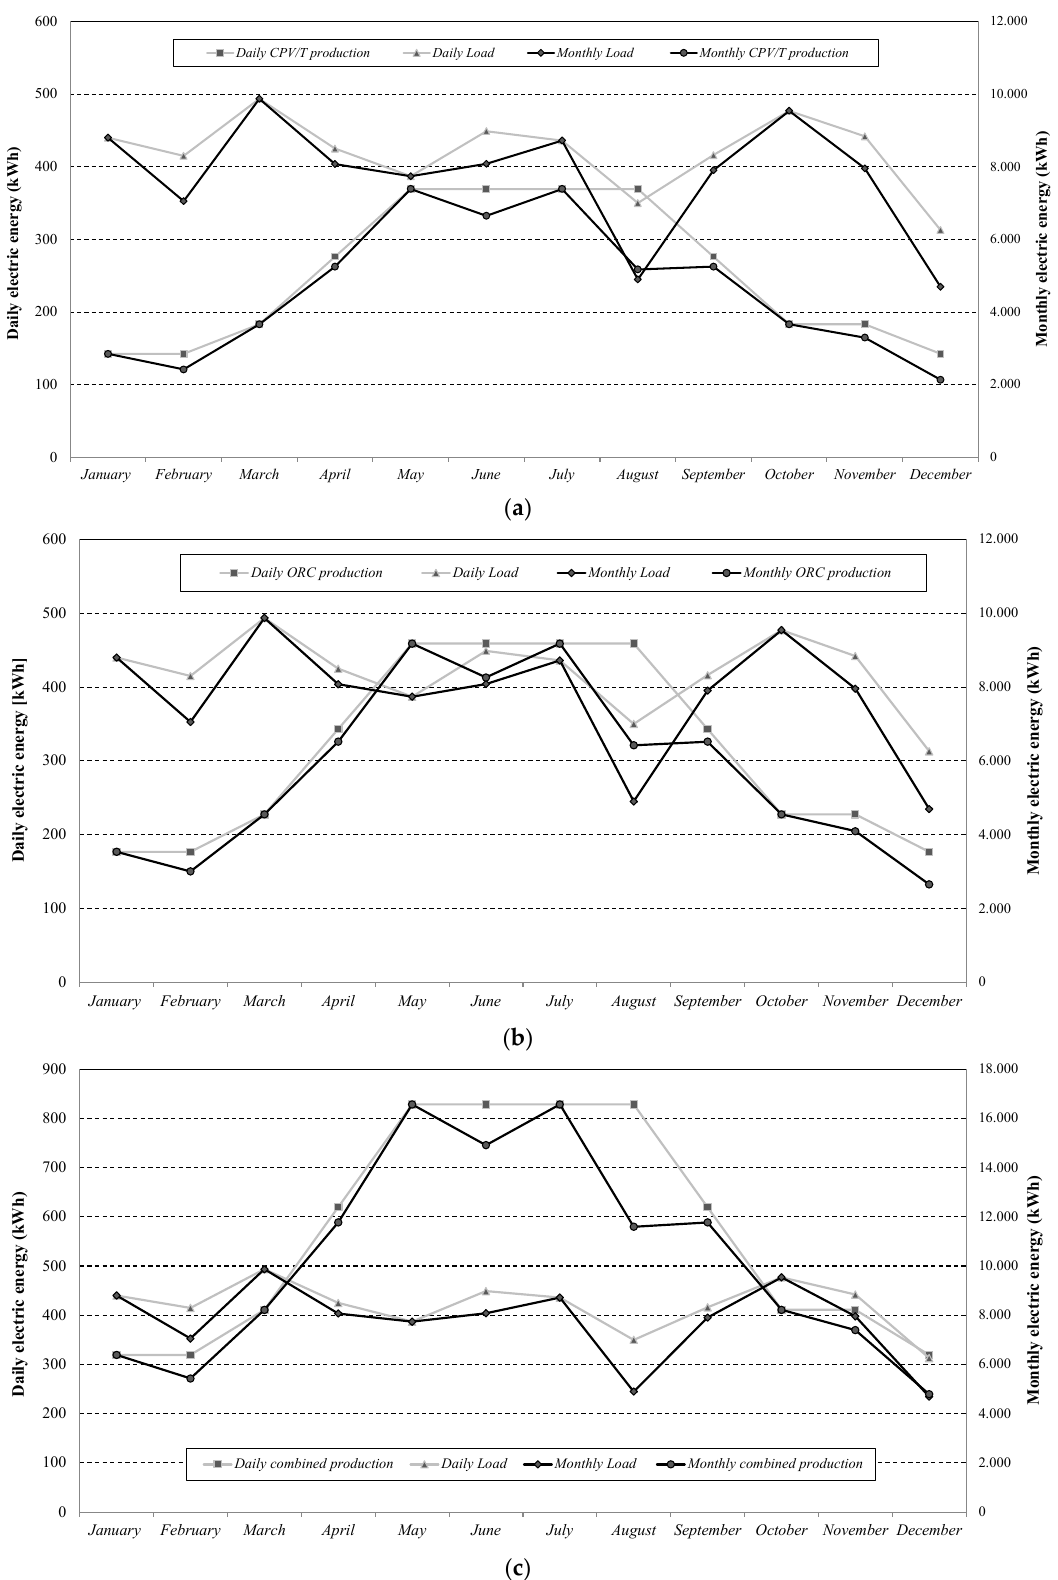
Figure 10. The CPV / T-ORC system electrical production compared to the user electrical loads: ( a ) Only the CPVT system; ( b ) only the ORC system; ( c ) combined production.